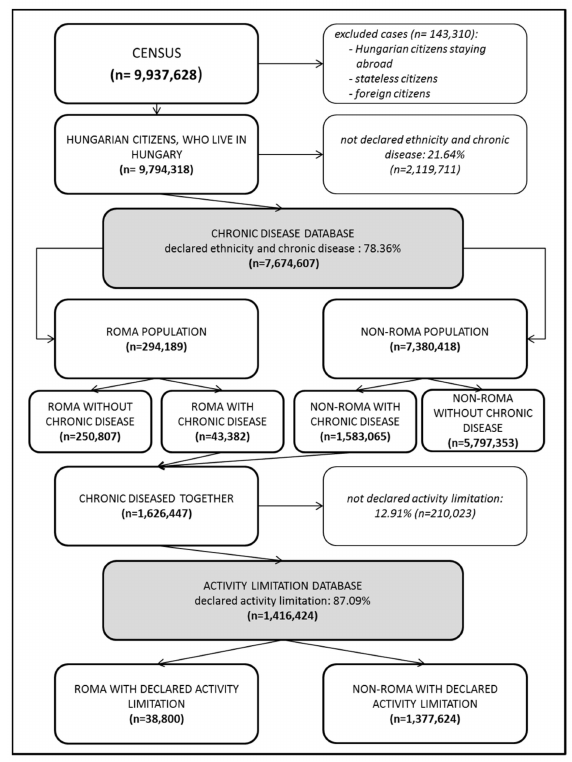
Figure 1. Studied groups’ selection from Hungarian census 2011 population. Table 1. Demographic characteristics of the study population and the di ff erences between the Roma and non-Roma population evaluated by χ 2